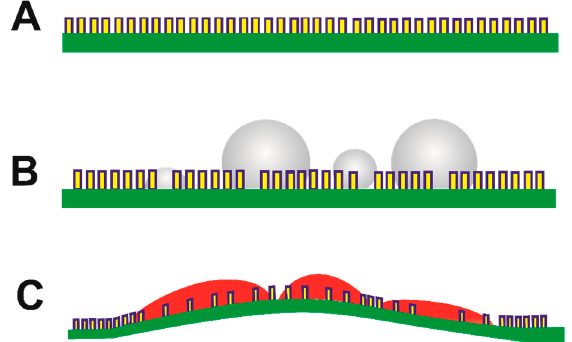
Figure 7. Schematic depiction of the putative membrane curvature mechanism involving ( A , B ) specific interactions of mammillae-decorated (yellow) collagenous membrane (green) and mineral precursors (grey); ( C ) the enrichment of mineral precursors and phase transformation to crystalline forms (red) induce surface localized swelling of the membrane and subsequent membrane deformation and curvature.